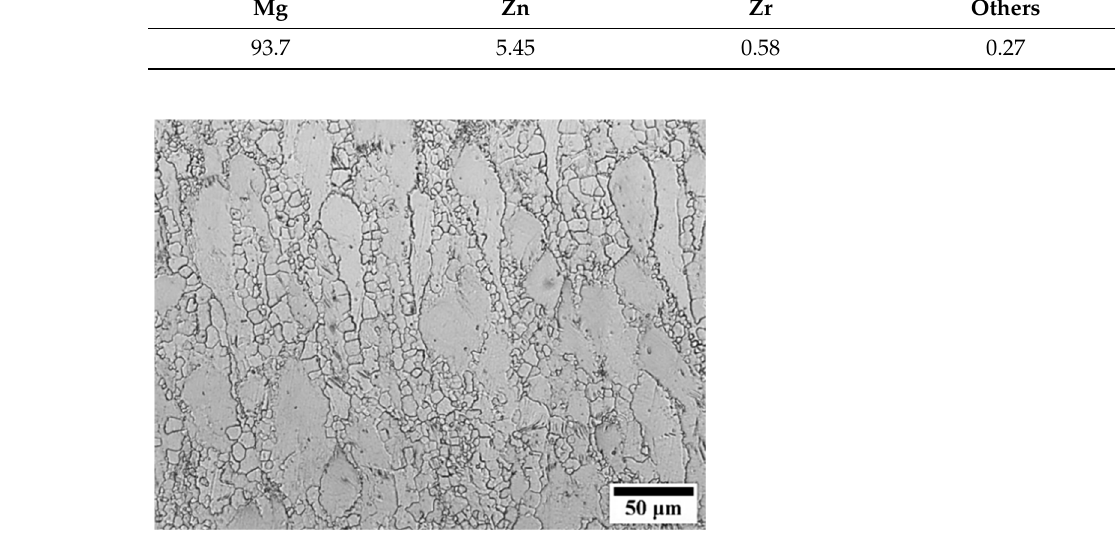
Table 1. Chemical compositions (wt%) of ZK60A-T5.